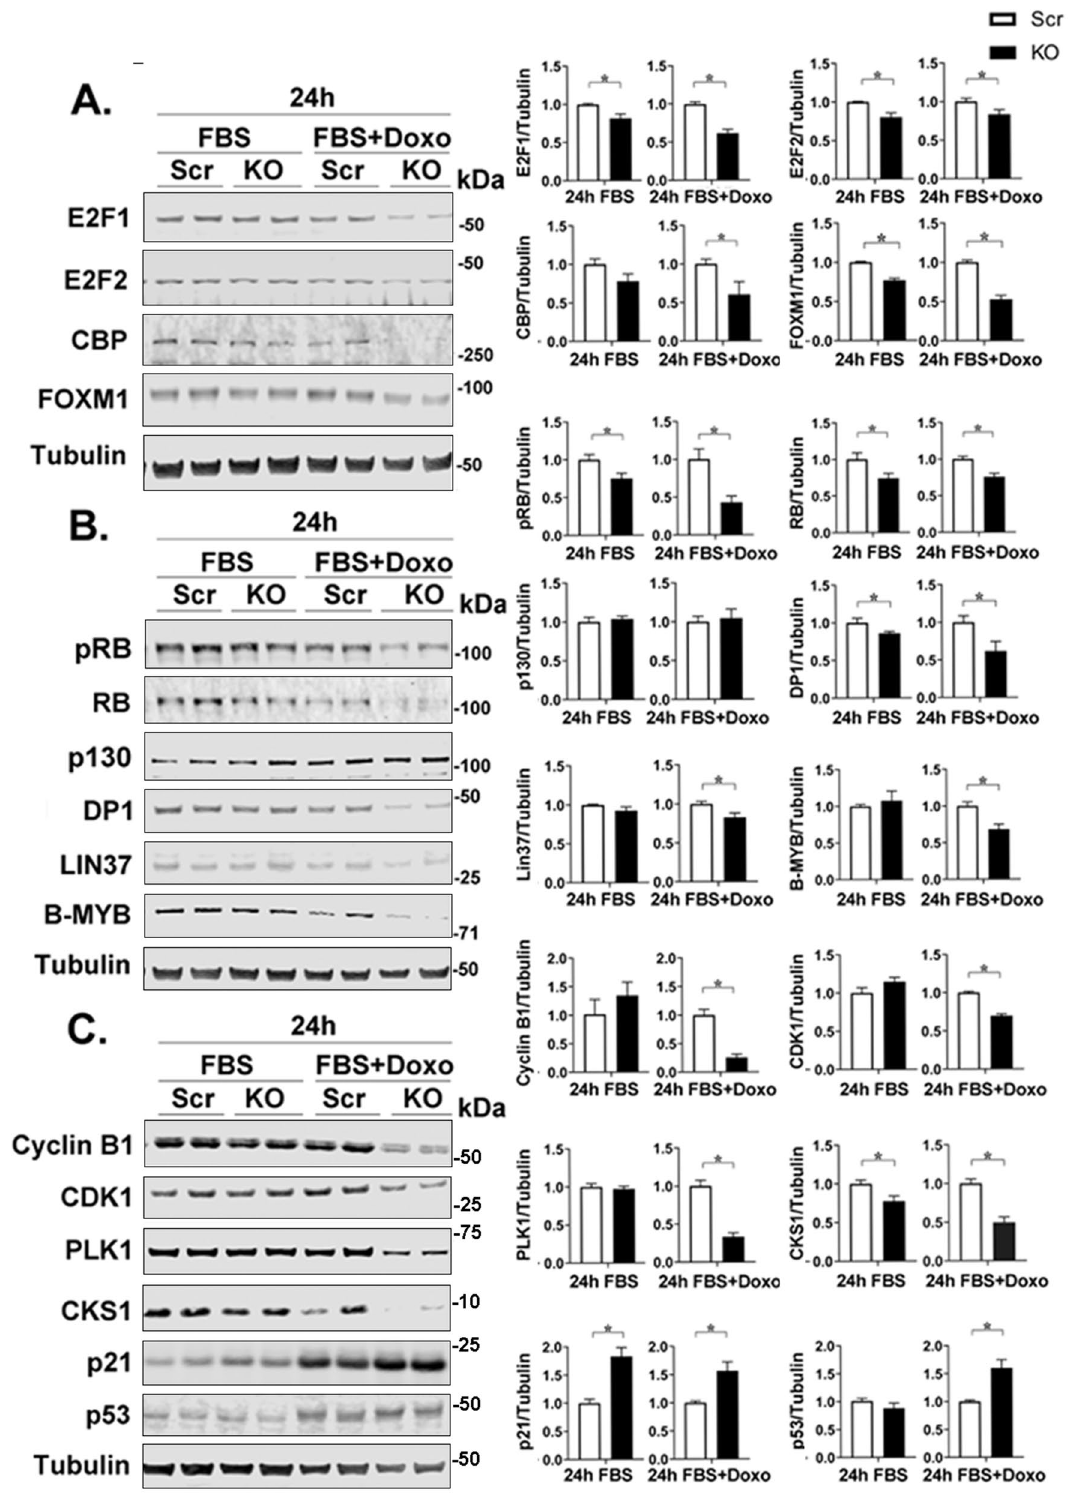
Figure 3. TRPM2 KO reduces expression of E2F1/2, FOXM1, and DREAM complex and cell cycle proteins. Western blotting was performed on two clones of TRPM2 KO and scrambled SH-SY5Y cells after serum deprivation followed by refeeding with 10% FBS with or without 0.3 µM doxorubicin for 24 h. Representative Western blots demonstrate expression of ( A ) transcription factors E2F1, E2F2, CBP, FOXM1, and tubulin control; ( B ) regulatory proteins pRB (pS795), RB, RB-like pocket protein p130, DP1, DREAM/MuvB complex member LIN37, and B-MYB; ( C ) downstream transcriptional targets of FOXM1 including Cyclin B1, CDK1, PLK1, CKS1, p21 and p53. Samples (Scr, KO) for each blot were derived from the same experiment and always processed in parallel. The different probes for each antibody are made explicit with white space and delineated with a black box. Densitometry measurements from three experiments for each protein were standardized to tubulin and to each experiment’s scrambled control. Means ± S.E.M. for each group are shown on the right. Statistics: unpaired t test, *p < 0.05. Full length gels for Western blots are shown in Supplementary Fig.